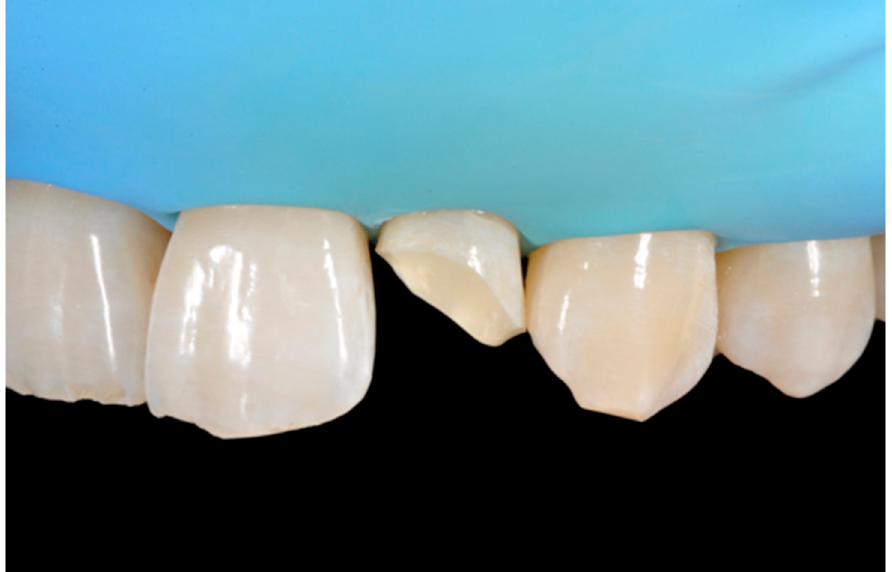
Figure 22. After isolation preparation is performed. Reprinted from Restauri diretti nei settori anteriori, G. Paolone, S. Scolavino, © 2021, with permission from Quintessence Publishing Italy.